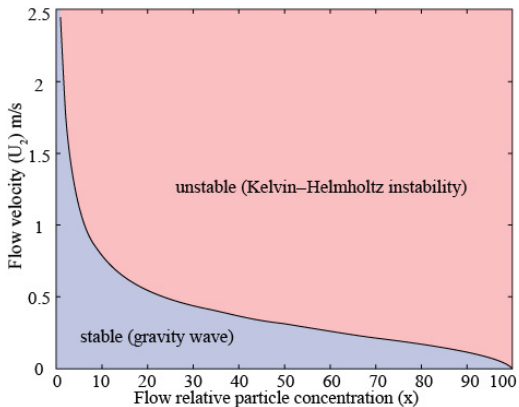
Figure A1. Threshold flow velocity ( U 2 ) as a function of flow’s particle concentration compared to bed’s particle concentration ( x ) following Eq.